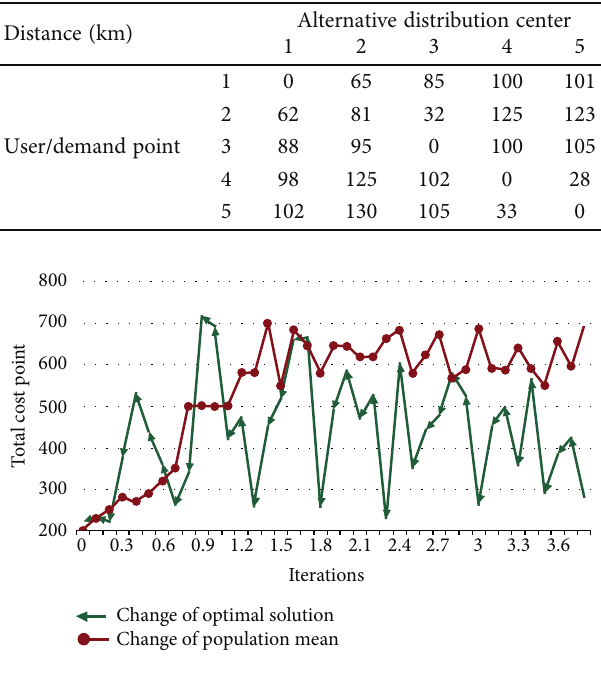
Figure 5: Iterative results of the algorithm of the distribution center location calculation